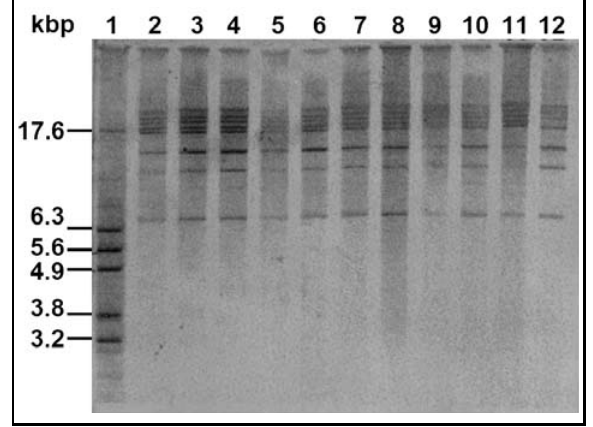
Figure 1 – Ribotypes of S. Enteritidis after hybridization with DIG-labeled 16S+23S cDNA probe. Lane 1: molecular weight marker Haemophilus aegyptius 3031 EcoRI DNA digest. Lanes 2 to 11: ribotype A, after digestion with SphI. Lane 12: ribotype B, after digestion with